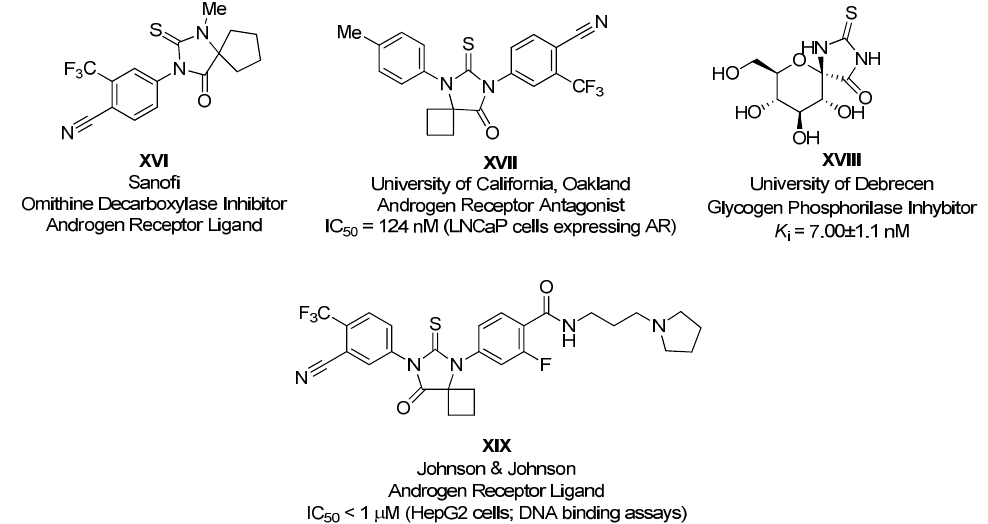
Figure 3. Examples of physiologically active spiro -thiohydantoins.